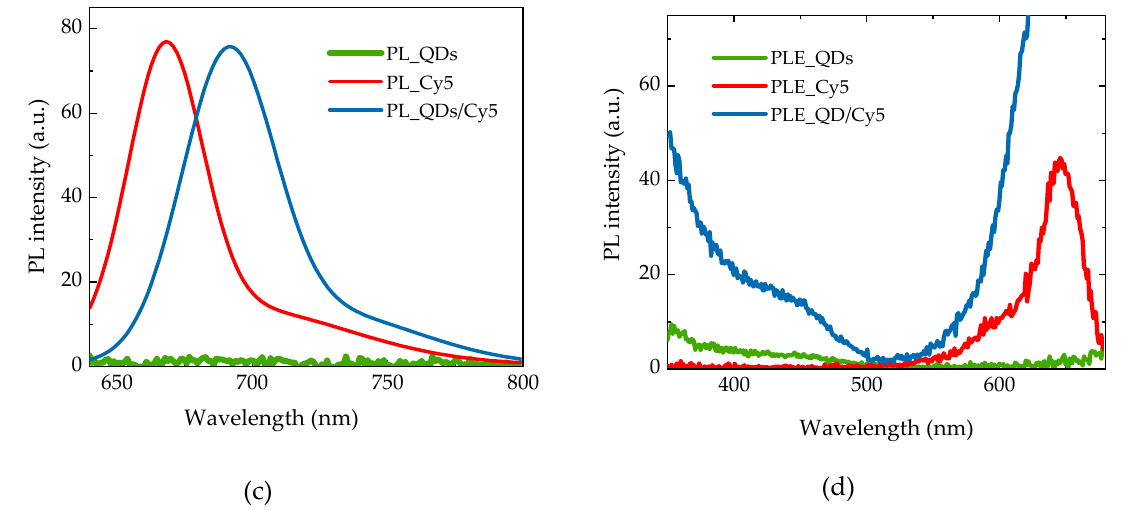
Figure 3. Absorption spectra of mixing solutions of AIS QDs and Cy3 ( a ) and Cy5 ( b ) at different molar rations of dyes and QDs ( n = C dye /C QDs ); ( c ) PL spectra of QDs and Cy5 in solutions, and Cy5 in the complex with QDs, excitation at 620 nm; ( d ) PL excitation spectra (EPL) of QDs and Cy5 in solutions, and Cy5 in the complex with QDs. Detection wavelength of 700 nm corresponds to peak of the Cy5 PL in the complex.